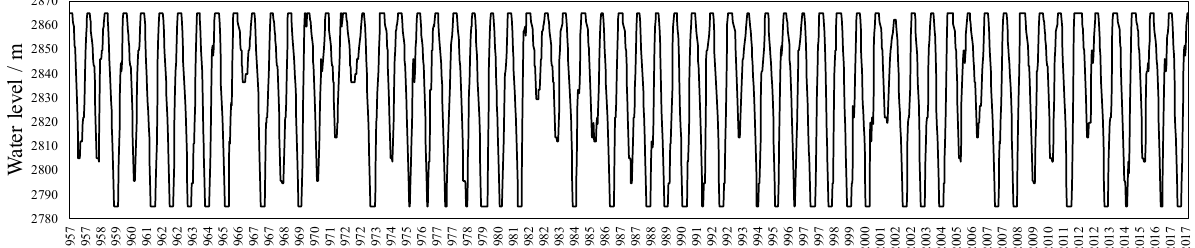
Figure 5. Overyear optimal water level process of Lianghekou reservoir based on multidimensional DP.